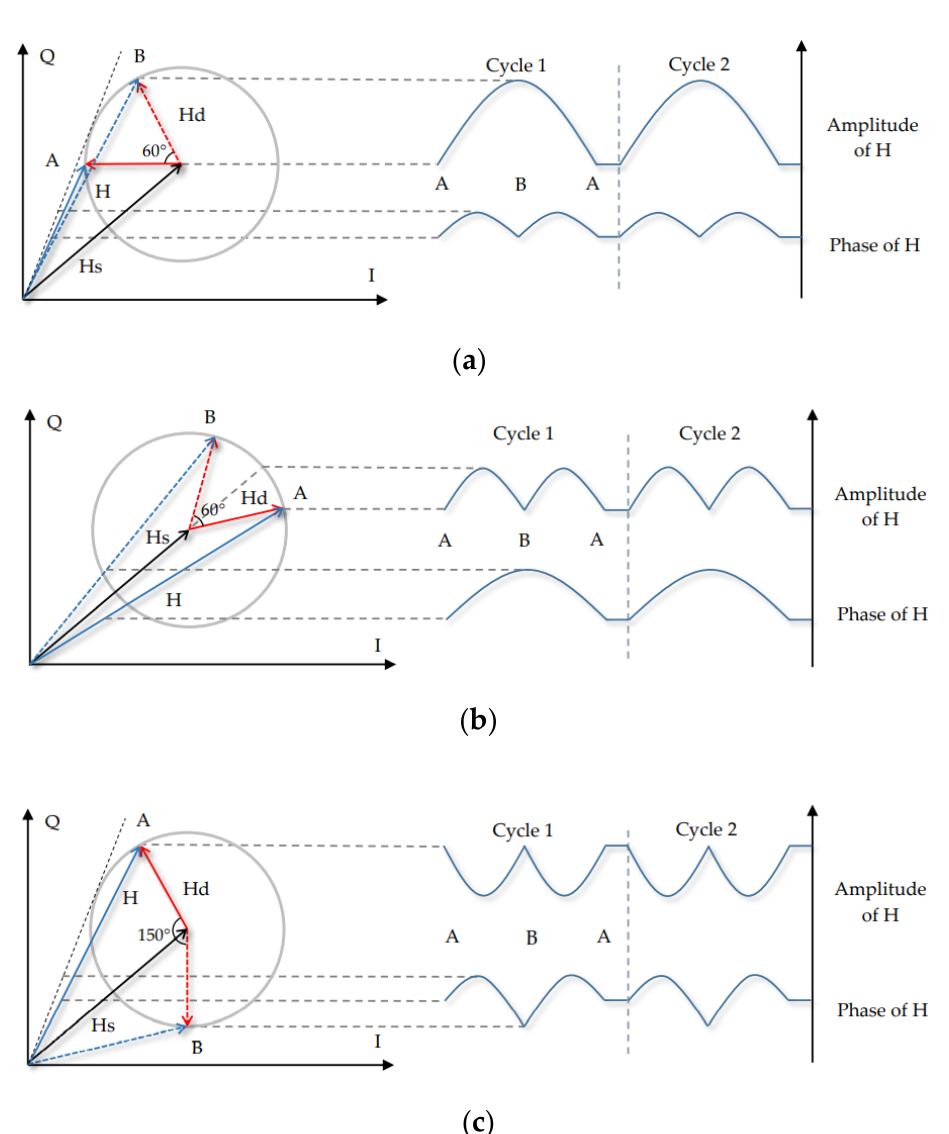
Figure 3. Variations of the resultant CSI amplitude and phase at different depths in various locations. ( a ) Case 1. ( b ) Case 2. ( c ) Case 3.